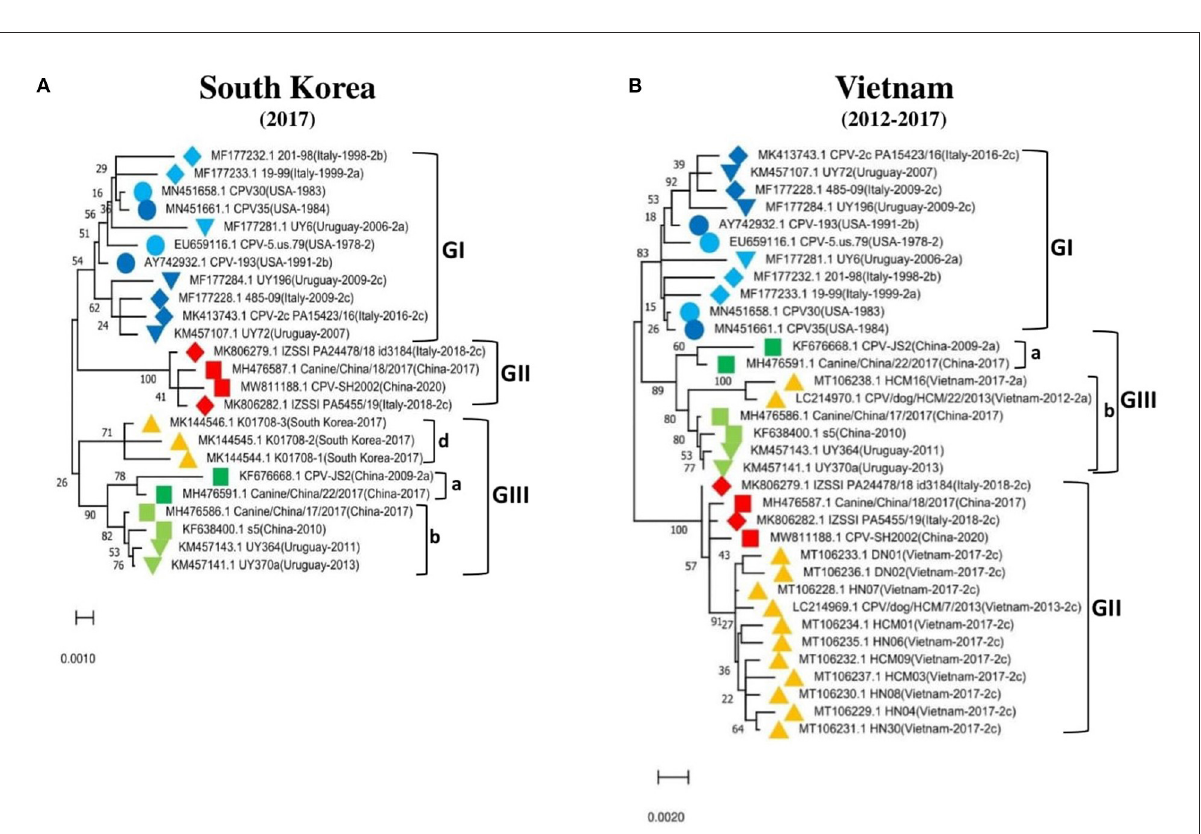
FIGURE3 Phylogenetic analysis based on the full-length genome of CPV-2 strains from (A) South Korea ( n = 3), (B) Vietnam ( n = 13). Trees were generated using the Maximum-Likelihood approach and MEGA 11 software. The numbers at each branch indicate the percentage of bootstrap values of 1,000 replicates. The evolutionary distances were computed using the Maximum Composite Likelihood method. The scale bar reveals the number of inferred substitutions per site. The CPV-2 strains are identified in a format as [GenBank ID_Virus name (country-collection year-antigenic type in GenBank)]. Yellow triangles indicate the strains from the country concerned by the analysis. Blue, red, and green colors indicate the standard reference sequences.